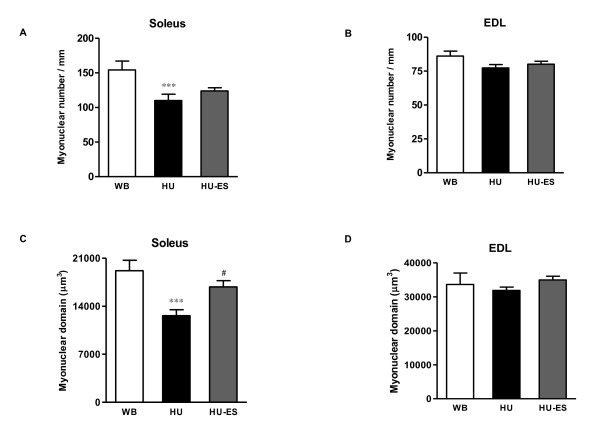
Myonuclear number and domain size. (A, B) Numbers of myonuclei per millimeter fiber length, and (C, D) Myonuclear domain size for WB, HU, and HU-ES groups. *** P < 0.001, significant difference between WB and HU groups; # P < 0.05, significant difference between HU and HU-ES groups. n = 4. Data are means ± SEM.